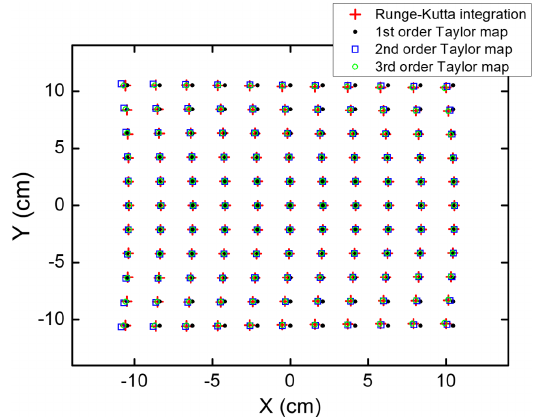
FIG. 10. Single particle distributions at the isocenter for differ- ent scanning angles with a 15 mrad interval for both transverse planes, from 0 to 50 mrad. Colors of symbols indicate the tracking methods: red, Runge-Kutta integration; black, first-order Taylor map; blue, second-order Taylor map; green, third-order Taylor